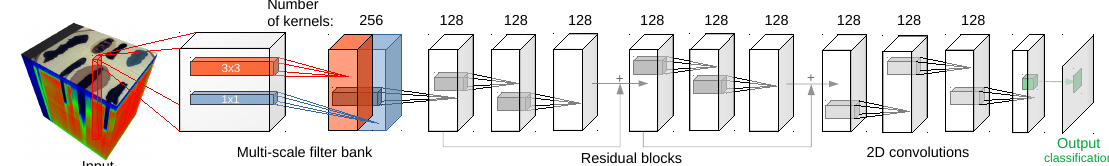
Figure 5. Schematic of the 2D CNN architecture [24] used in